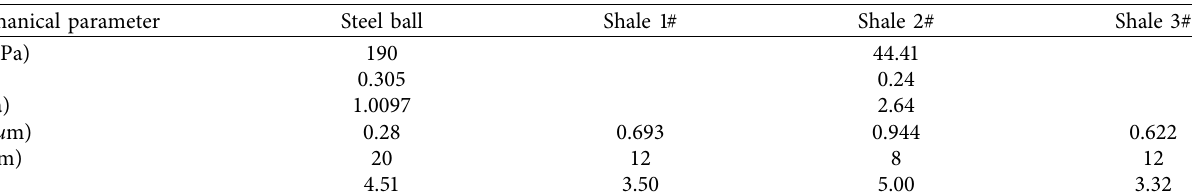
Figure 3: SEM pictures of indentation. (a) Dot matrix. (b) Single. Table 2: Mechanical parameters and plasticity index of steel/shale specimens.